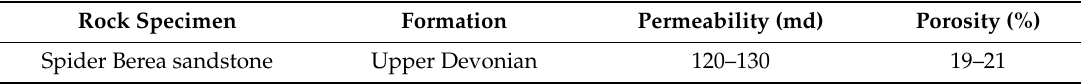
Table 1. Test Specimen Properties [41].